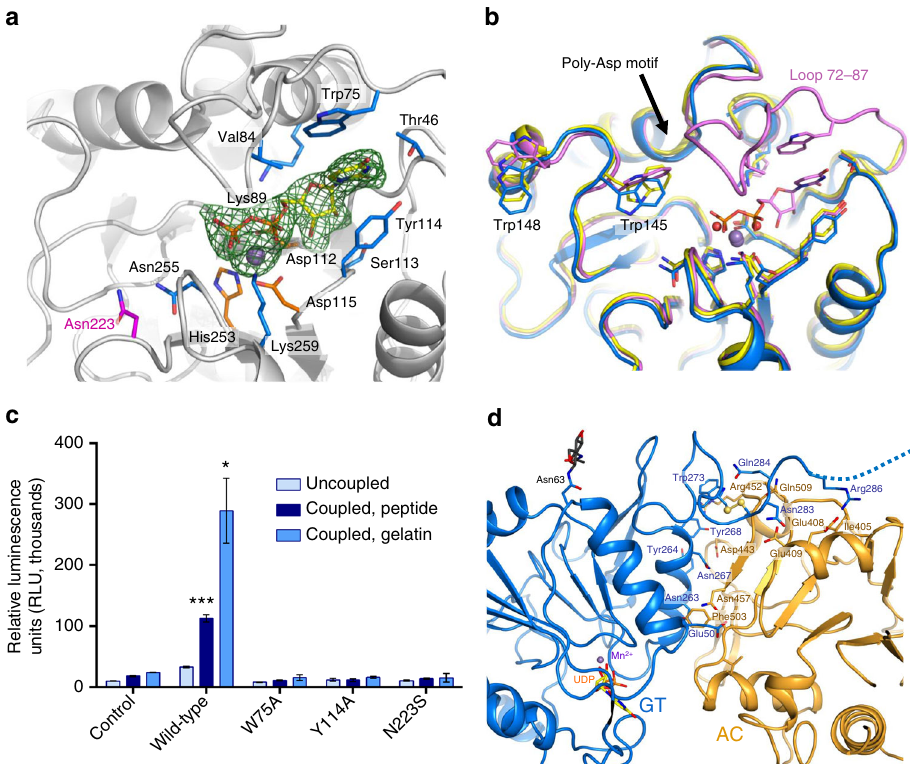
Fig. 2 Insights into LH3 glycosyltransferase activity. a Co-crystallizations with Mn 2 + and donor substrates revealed clear electron density ( 2F o -F c omit electron density maps, green mesh, contour level 1.2 σ ) for the metal ion and for UDP in the catalytic site of the N-terminal GT domain. Residues involved in coordination of the metal ion are shown with orange sticks, while residues interacting and stabilizing UDP binding are shown in blue. Residue Asn223, found mutated into a Ser and causing pathogenic phenotypes similar to osteogenesis imperfecta, is shown with magenta sticks. b Binding of donor substrates induces conformational changes in the GT domain. Shown is a superposition of ligand-free (yellow), Mn 2 + -bound (blue), and Mn 2 + -donor substrate-bound (violet) structures of LH3 GT domain. Only the UDP-Gal-bound structure is shown; the conformation observed in UDP-Glc-bound structure is identical. Flexible loop 72 – 87 becomes well de fi ned only in donor substrate-bound structures; in these structures, residues Trp145 and Trp148 adopt different conformations. c Luminescence-based assays for the evaluation of LH3 GT enzymatic activity show that mutants W75A, Y114A, and N223S are inactive. Control experiments were performed without adding enzyme. Error bars represent standard deviations from average of triplicate independent experiments. Statistical evaluations based on pair sample comparisons between uncoupled and coupled assay values using Student ’ s t -test. * P -value